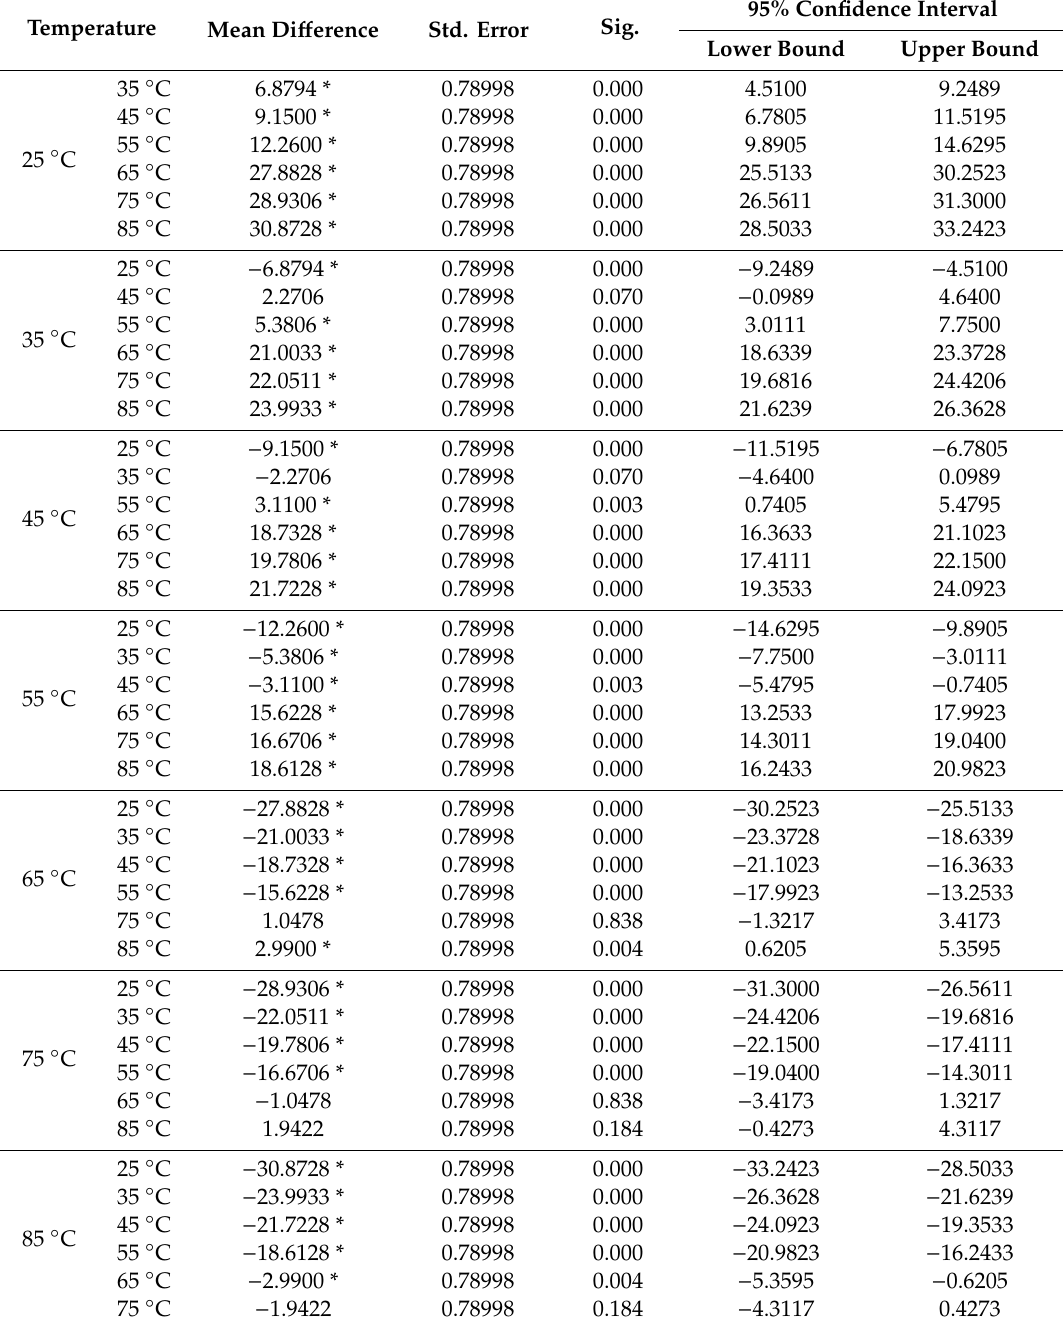
Table A2. Multiple comparisons of catalase activity at di ff erent